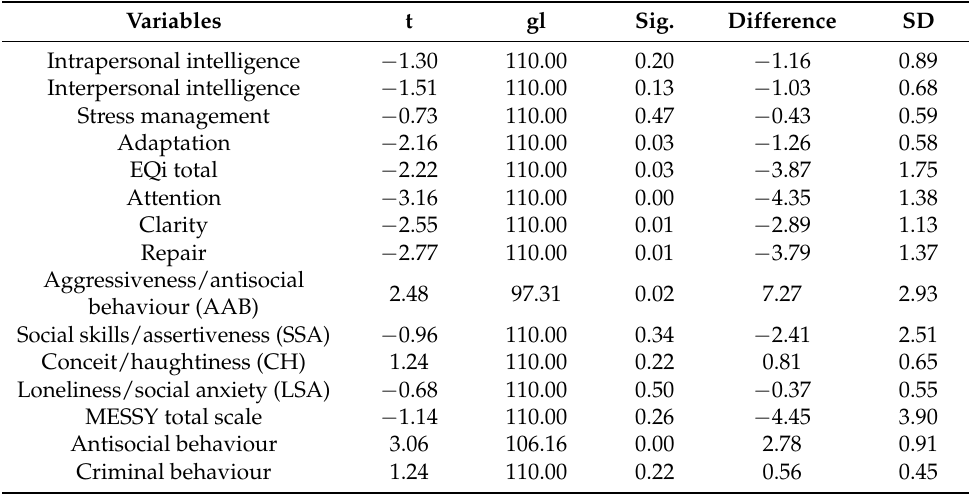
Table 2. Student’s t -test results for difference in mean scores (before